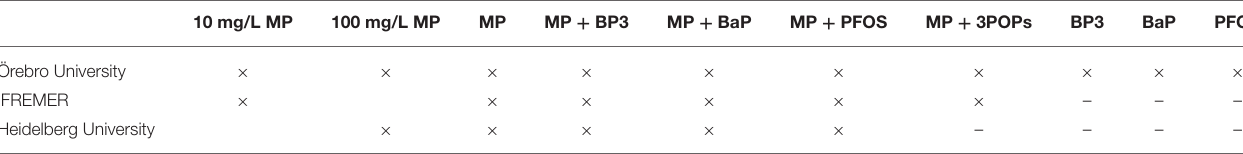
TABLE 3 | Exposure scenarios tested by the three laboratories for MPs, adsorbed MPs [MP + pollutant(s)] and pollutants alone.